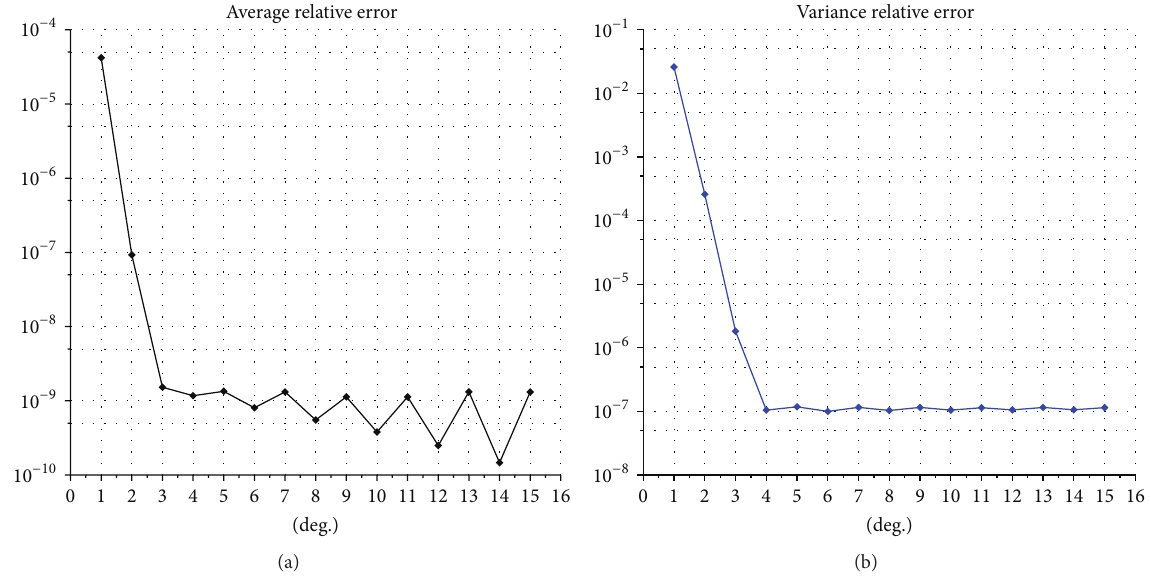
Figure 4: Semilogy scale plot of the absolute value of the relative error of the mean (a) and the variance (b) computed via PCE for GBM at time 𝑇 = 1 , whose parameters are 𝑟 = 3 %, 𝜎 = 15 %, and starting value 𝑆 0 = 100 , for a set of degrees 𝑝 = {1,2, .. . ,15} .